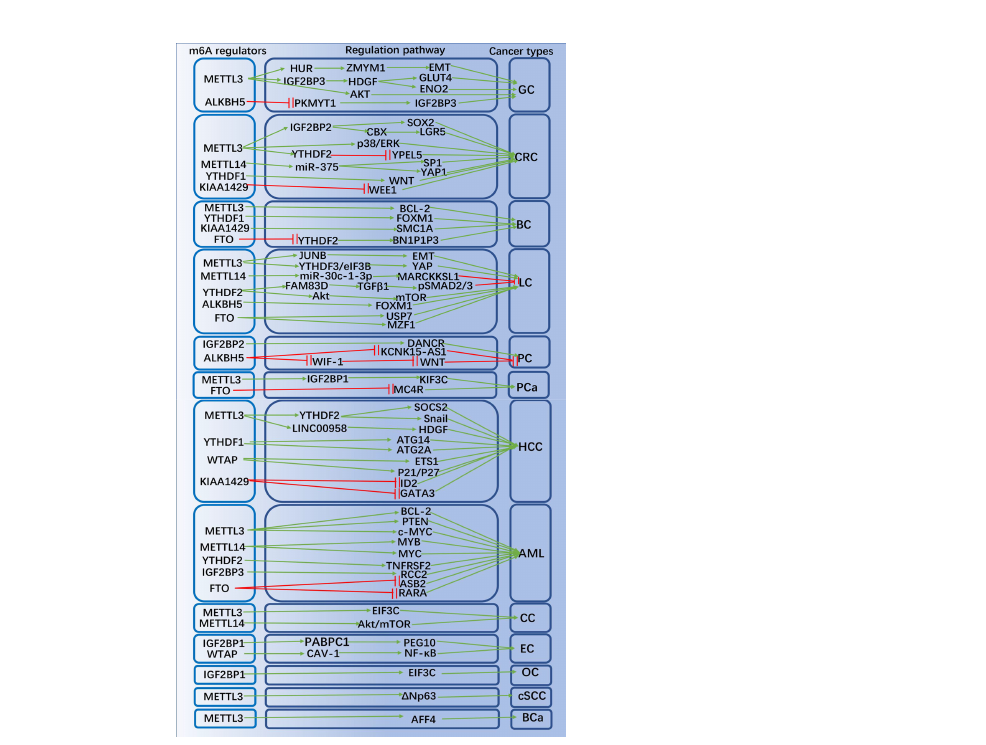
FIGURE 3 | The potential role of m6A modi fi cation in peripheral cancers progression and related mechanisms. The m6A regulators promote or inhibit peripheral cancer progression by affecting the expression of tumor-associated